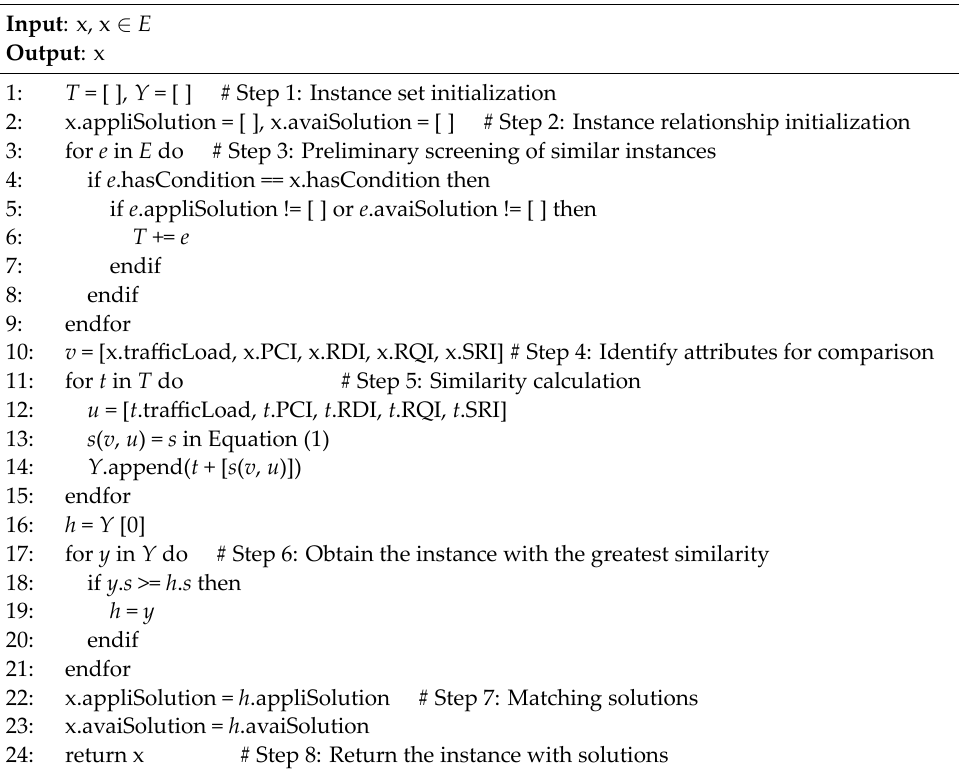
Algorithm 2. Expressway renewal based on case similarity